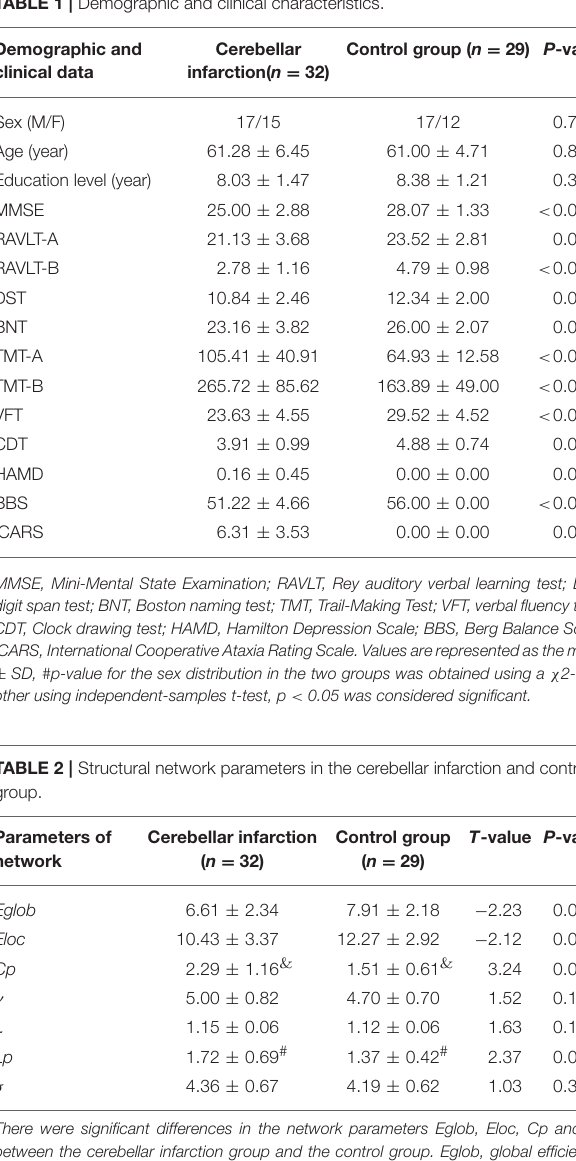
TABLE 1 | Demographic and clinical characteristics.